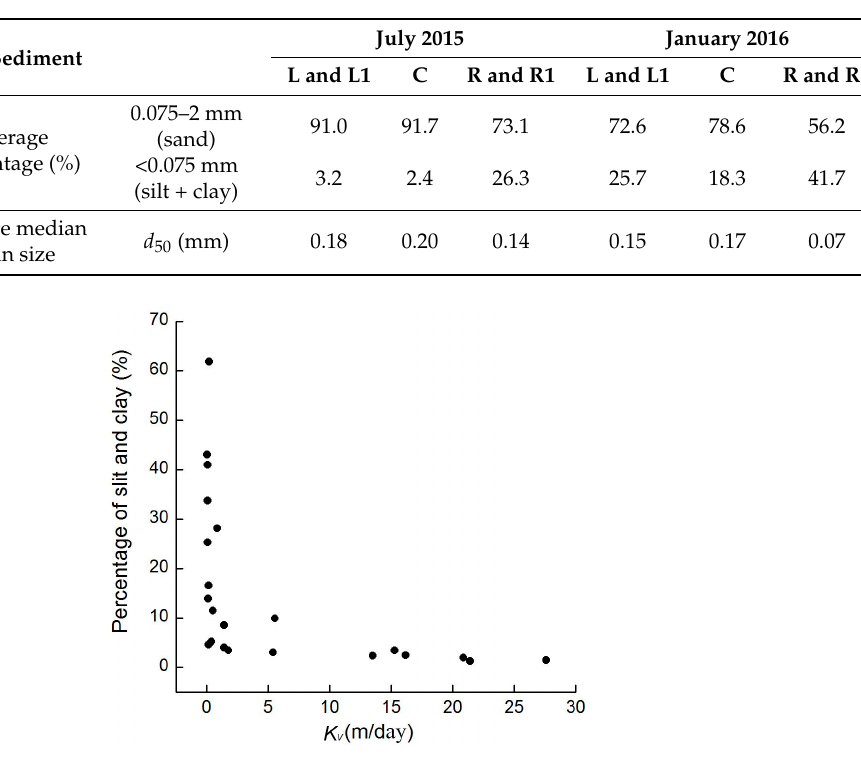
Table 3. Sediment grain size distributions at the channel bend during July 2015 and January 2016.